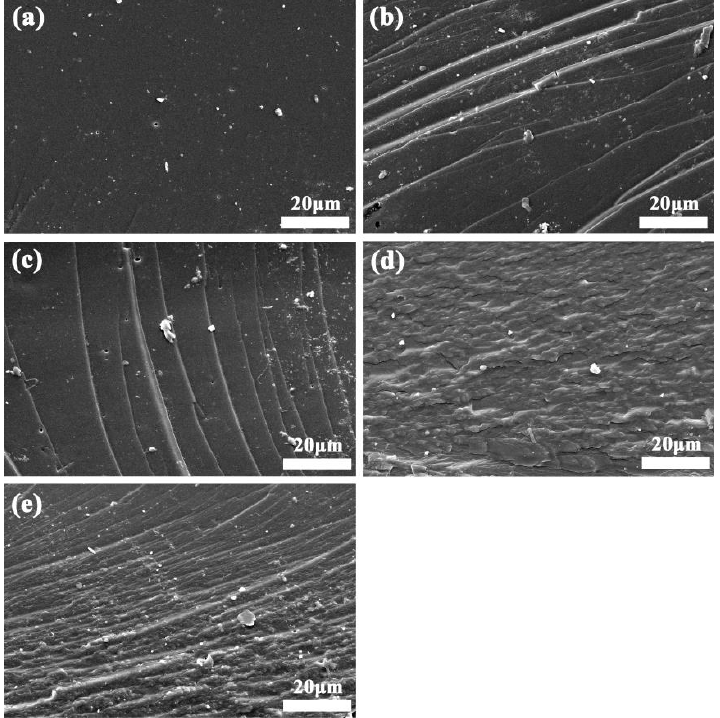
Figure 3. Scanning electron microscope (SEM) images of ( a ) SPI, ( b ) SPI/G, ( c ) SPI/CNT, ( d ) SPI/NFC, and ( e ) SPI/G/CNT/NFC nanocomposite films.